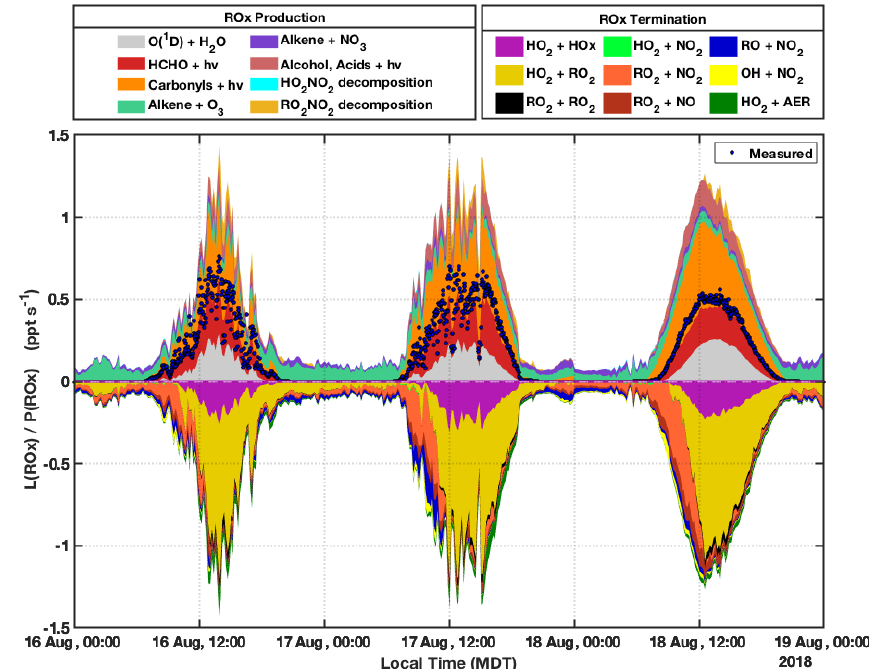
Figure 8. Modeled RO x production and termination for 16, 17, and 18 August. The results provided were modeled with F0AM using the MCM-BBVOC-het mechanism. Net rates are provided for reversible processes. RO x termination L (RO x ) and RO x production P (RO x ) are separated into several straightforward categories as represented in their respective legends. Heterogeneous HO 2 loss is represented by the HO 2 + AER (AER = aerosol) category. P (RO x ) derived from direct measurements, as presented in Fig. 3, is shown for comparison and is represented by the blue markers. The modeled results are shown in 10min intervals and were averaged from the 2min basis, while measurement-based P (RO x ) is shown in 2min